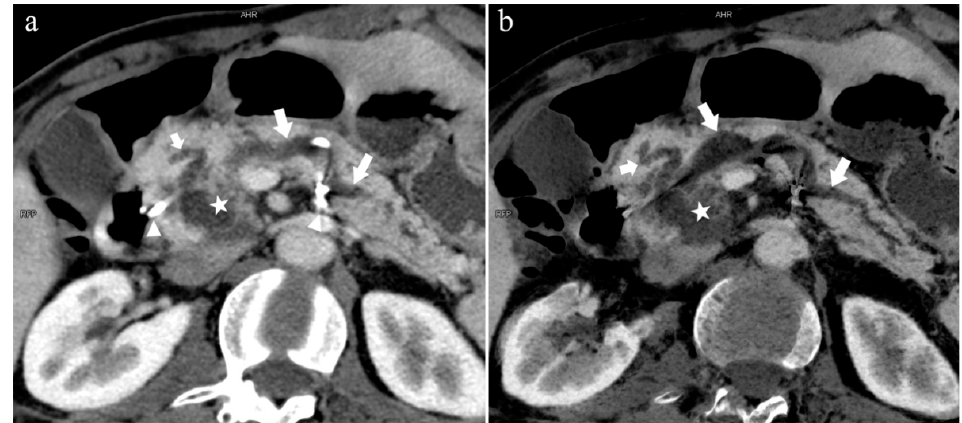
Figure 8. Type 4c. A 73-year-old female patient with multiple stones of the intrahepatic bile duct. ( a ): MIP [45keV MEI(+)] shows that MPD (long arrow) flows into MiP, and APD (short arrow) flows into MP with a small communication branch (bent arrows) between them. ( b ): MinIP [45keV MEI(+)] improves visualization of small pancreatic ducts and their branches. MPD refers to anatomically large and functionally dominant ducts.